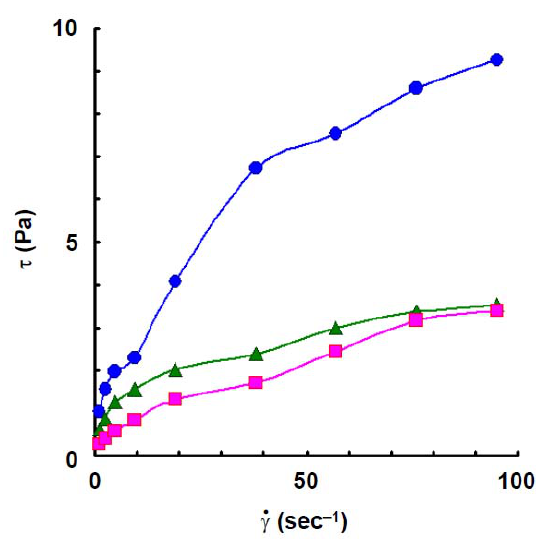
Figure 1. Flow curves, at 25 °C, of wheat amylose at various concentrations. Concentrations: 1.2%, ■; 1.4%, ▲; 1.6%,